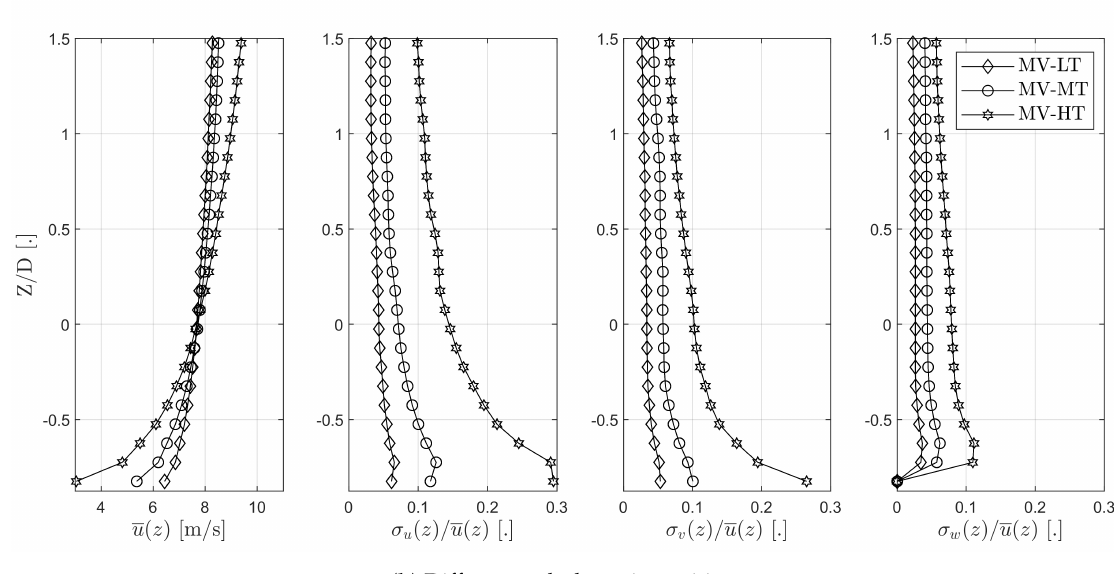
Figure 1. Inflow conditions in terms of average horizontal wind speed and longitudinal, transversal and vertical turbulence intensity. The panels on top ( a ) show three cases with the same turbulence intensity (medium) but different wind speeds, while the panels at the bottom ( b ) show three cases with the same wind speed (medium) at hub height but different turbulence intensities. The resulting average transversal and vertical velocities from the LES simulations are negligible.